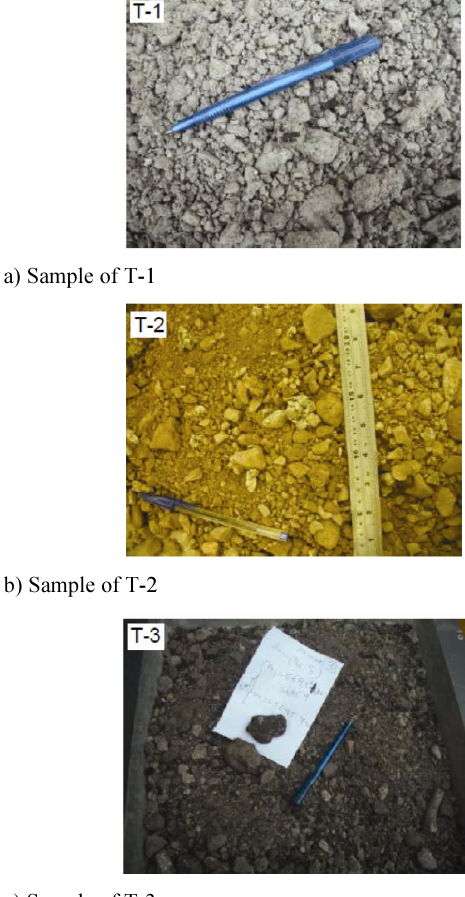
Fig. 1. Samples of T-1, T-2 and T-3